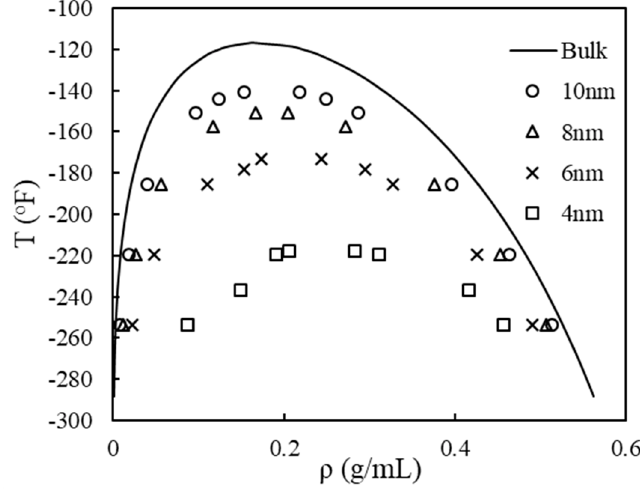
Figure 4. Simulated coexistence curves of methane in different sizes of capillary tubes uing LB method.